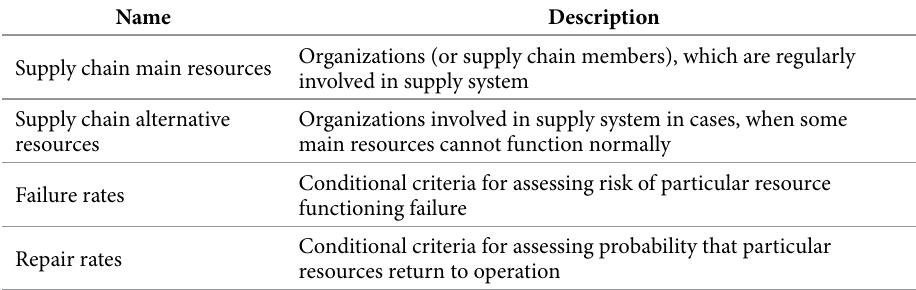
Table 2. Supply system general information